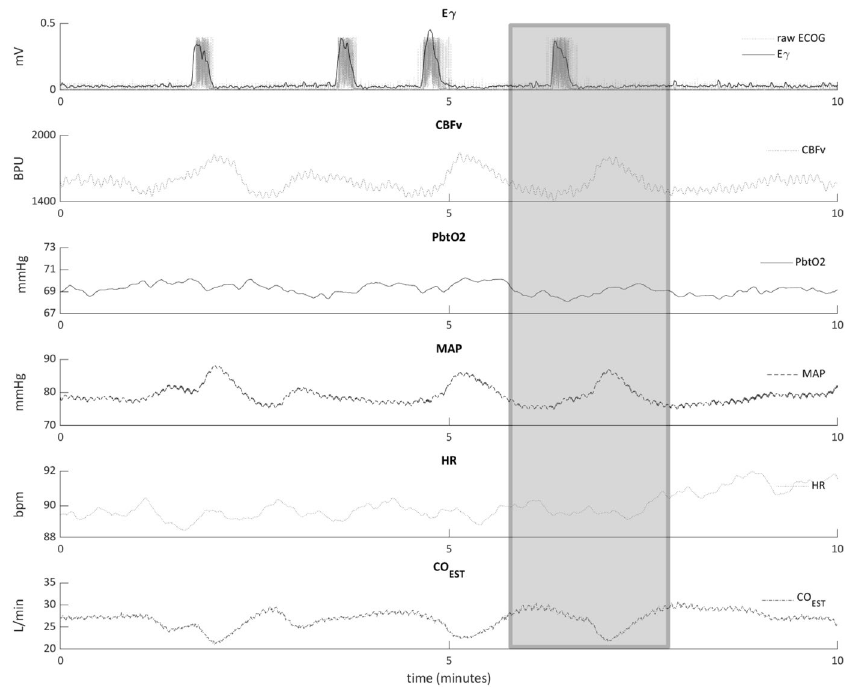
Figure 3. Multimodal cerebral and systemic recording in an animal with penicillin-induced seizures. Eγ EEG gamma envelope power, CBFv Cerebral blood flow velocity, PbtO 2 Partial tissue oxygen pressure, MAP Mean arterial pressure, HR Heart rate, CO EST Cardiac output estimation using the Liljestrand–Zander method. Time = 0 corresponds to the last penicillin application before seizure occurrence. Peaks in the gamma envelope of the ECOG signal corresponds to induced seizures on electrocorticography (Eγ—top row). Seizures are associated with time-locked variations in local CBFv (second row), PbtO2 (third row) and systemic parameters (MAP—forth row, HR—fifth row, and CO EST —last row). The epoch around a seizure is presented as example (grey rectangle); for more details, please refer to the